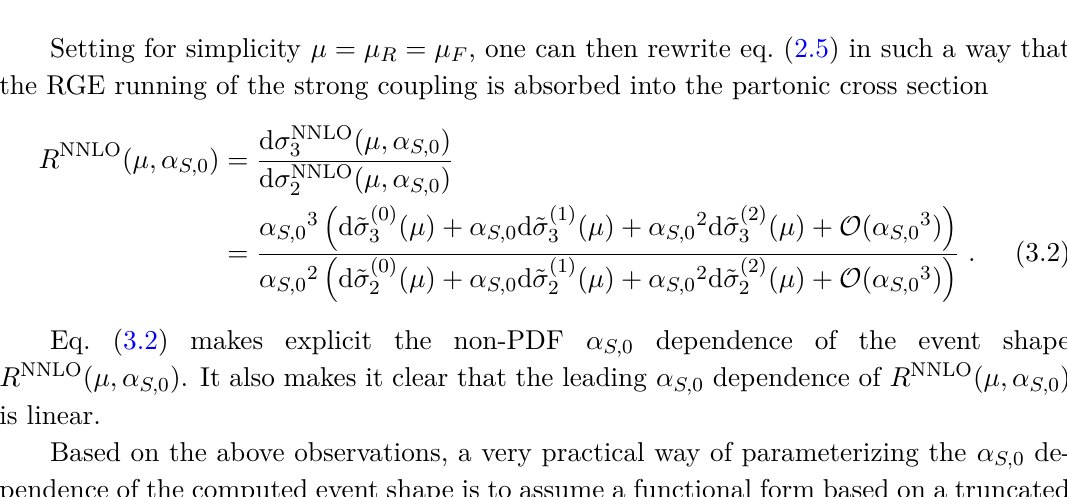
Table 1 . The values for α S, 0 = α S ( µ R = m Z ) available with each PDF